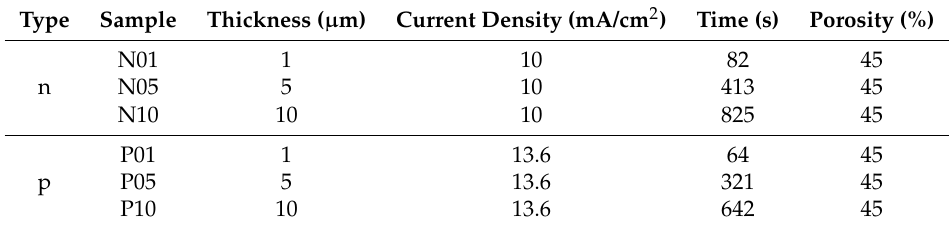
Table 1. Porous silicon